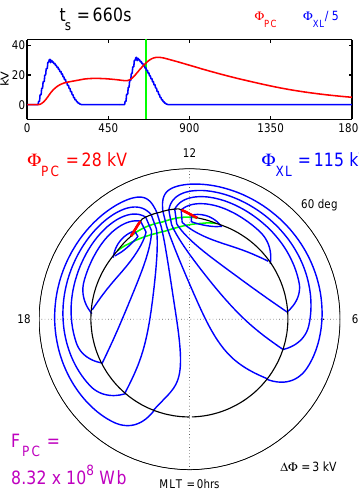
Fig. 6. An example of the output from the model. The top panel gives the variation with t s of 8 XL / 5 , where 8 XL is the input re- connection voltage (in blue) and of the resulting transpolar voltage 8 PC (in red). The vertical green line gives the simulation time t s of the convection pattern shown in the MLT-invariant latitude (3) plot beneath. In this lower plot, 12:00 MLT is to the top and 06:00 MLT to the right and the outer circle is 3 = 60 ◦ . Adiaroic (non-reconnecting) segments of the OCB are shown in black, re- connecting segments of the OCB in red. Equipotential contours, 18 = 3kV apart, are shown in blue. The green lines delineate flux opened by the two reconnection pulses. The current values of the voltages 8 XL and 8 PC and of the polar cap flux F pc are given in blue, red and mauve text,